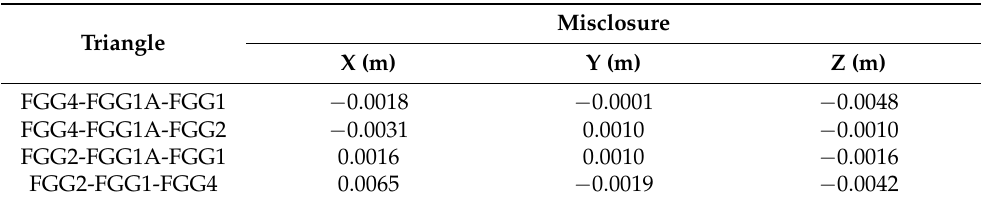
Table 11. Misclosures of triangles for the low-cost GNSS instruments.